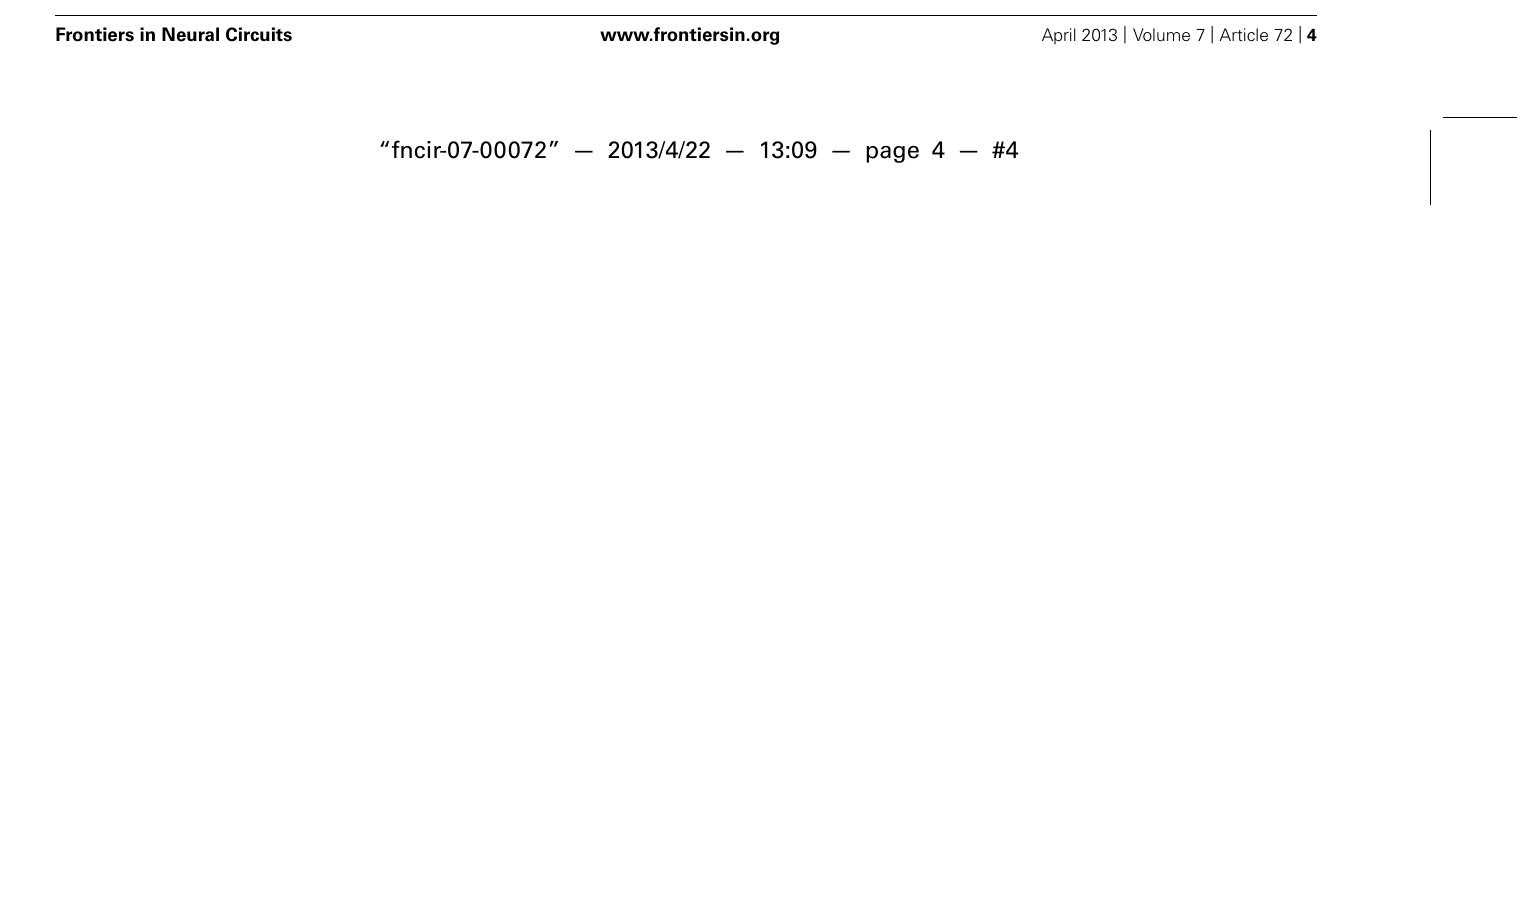
(D-homocysteic acid, DLH) into the vlPAG. Stimulation onset indicated by filled arrowheads. Each trace is an average of 15 trials. Each bar is the mean + SEM of n = 15 trials. * P < 0.05; ** P < 0.01. Scale bar values are the same for each trace. Reproduced with permission from Cerminara etal.